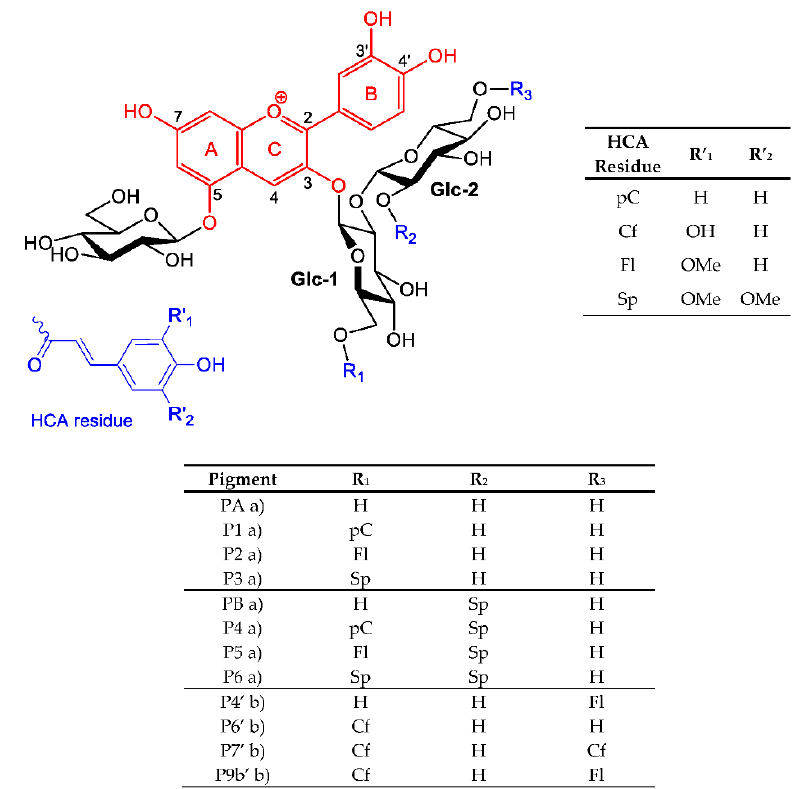
Scheme 1. Structure of the RC and PSP anthocyanins studied. When present, hydroxycinnamoyl residues R 1 , R 2 , and R 3 are p -coumaroyl (pC), feruloyl (Fl), caffeoyl (Cf), and/or sinapoyl (Sp). Note: a) from red cabbage; b) from purple sweet